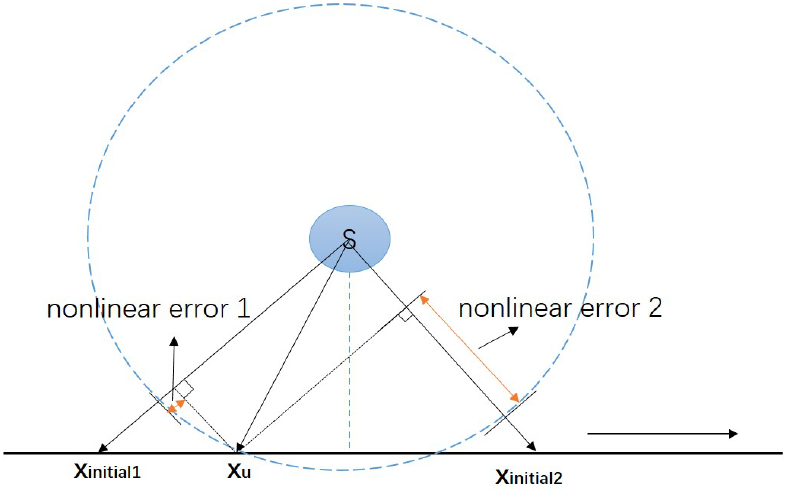
Figure 2. Nonlinear